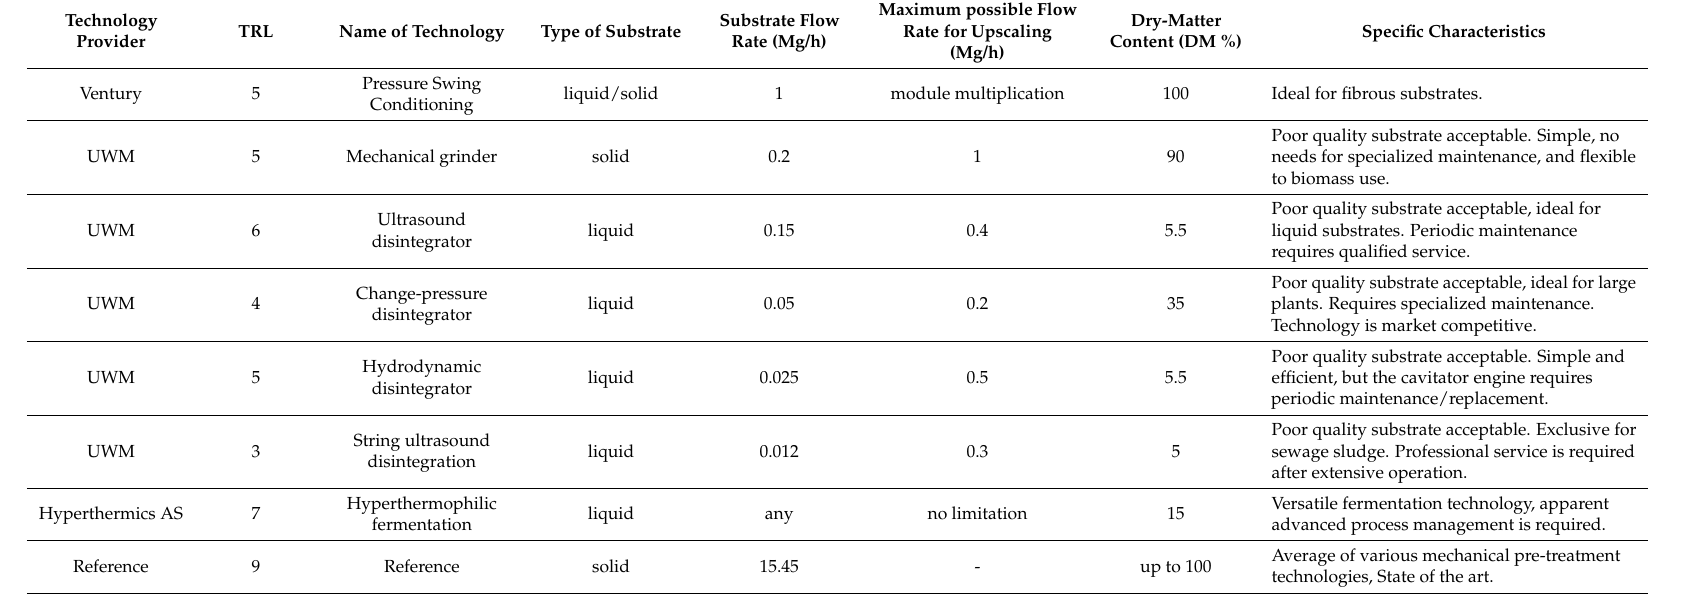
Table 3. Overview of selected data for pre-treatment technologies (data from Technology